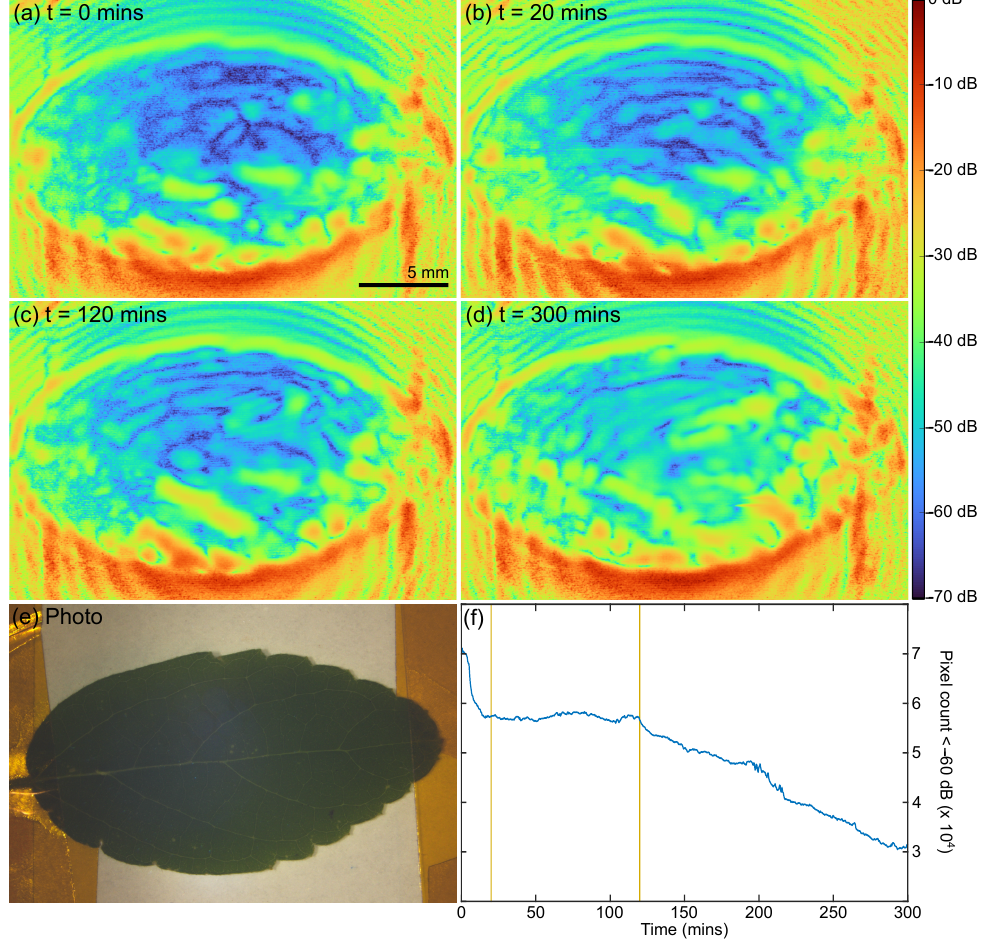
Figure 8. ( a – d ) LFI images of Celtis sinensis at t = 0, 20, 130, and 300 min. For a continuous progression from 0 to 300 min, see Video S2. ( e ) Photo of leaf after LFI scan (300 min +). ( f ) Change in count of ‘blue’ pixels (Amp. < 60 dB) vs. time. Horizontal lines indicate 20 and 120